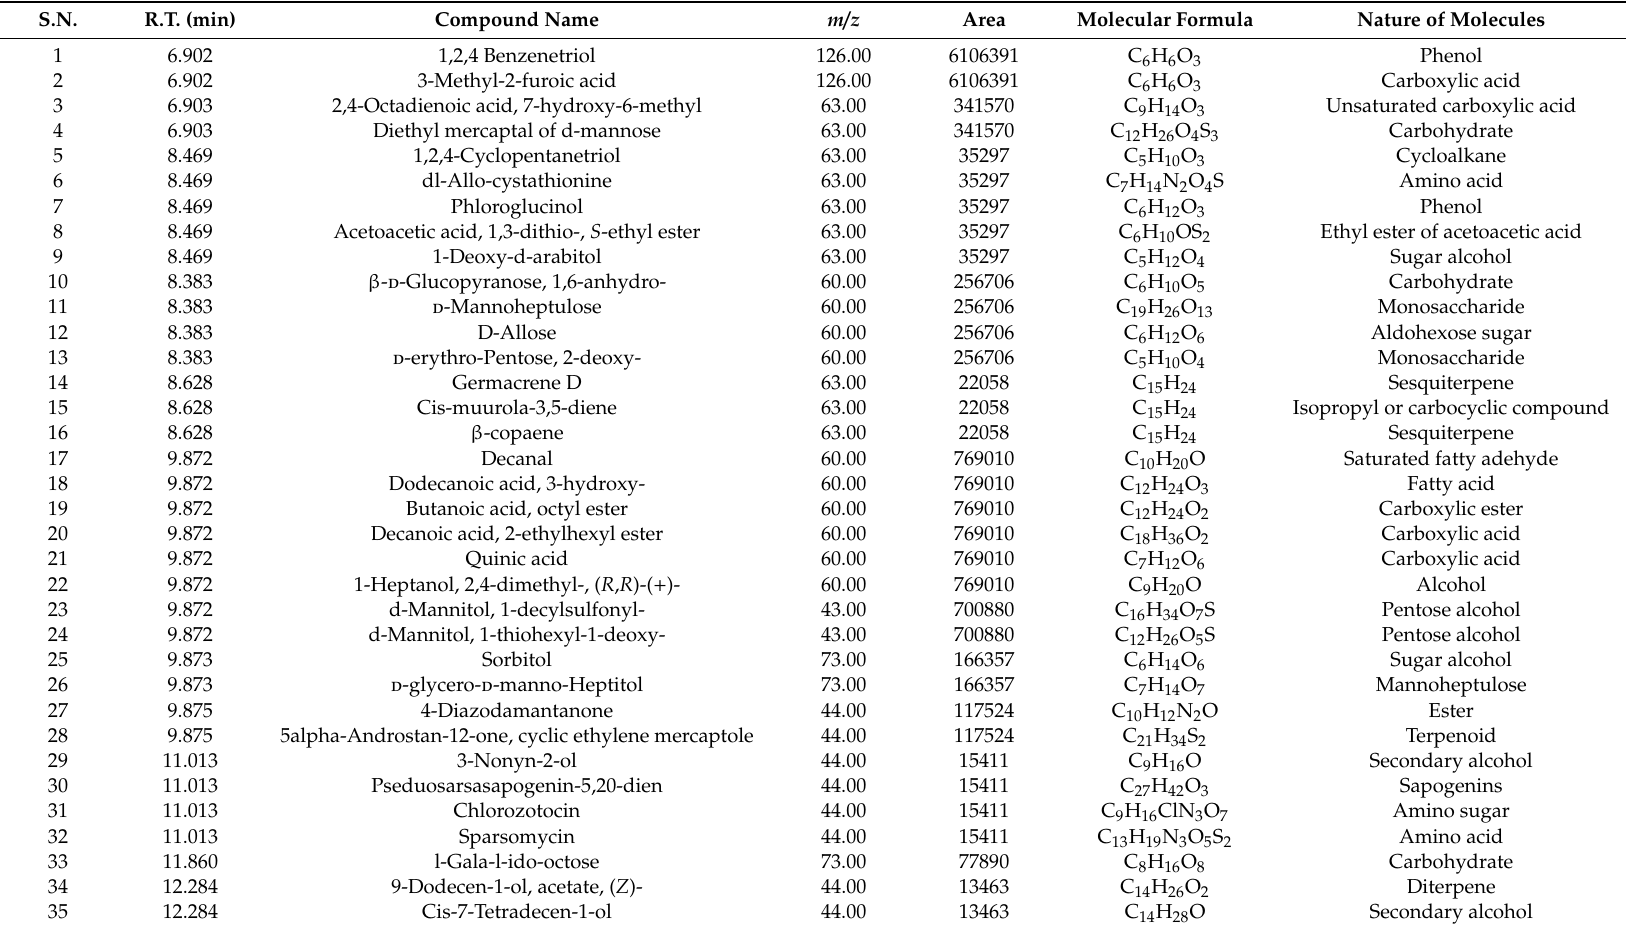
Table 1. Quantitative compounds identified from MECVL through the GC-MS